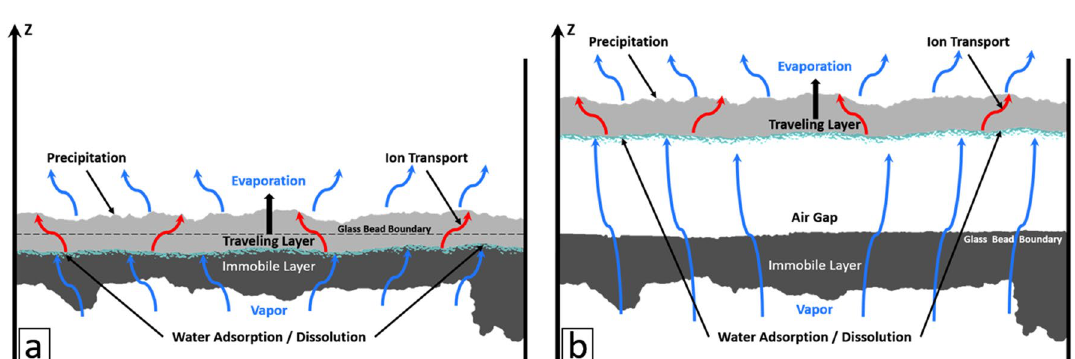
Figure 6. Schematic of displacement mechanism when the travelling layer is still embedded in the immobile layer ( a ) and after detachment ( b solution saturated crust pores, the brine NaCl concentration is expected to be very close to thermodynamic equilibrium. The vapor partial pressure at the surface of a NaCl saturated aqueous solution is p v − crust = 0.75 p vsat . These differences in vapor . As a result, the situation in the cell is p v − cell − bottom > p v − crust − surfaces > p v − cell − top partial pressures induce a water transport by diffusion between (1) liquid water at the cell bottom and the salt crust bottom and (2) the salt crust upper surface and the cell top. Consequently, the crust absorbs water at its bottom as the result of water vapor condensation whereas evaporation takes place at its top. Since the crust thickness does not change appreciably after detachment (Fig. 2), water does not accumulate significantly within the crust during the crust displacement. As a result, the water absorbed at the crust bottom is transported within the crust pore space up to the crust top surface, where it evaporates. This is an indication that the crust pore network is percolating. Hence, solute transport takes place through the crust while water vapor condensation at the crust bottom leads to crystal deliquescence 25 , i.e. dissolution, and evaporation at its top induces precipitation. This dissolution–precipitation displacement mechanism is sketched in Fig. 6. The displacement is quite slow. Thus, temperature variations associated with the liquid–vapor phase change processes occurring in the cell can be neglected. This scenario leads to the following relationships (adapted from ref. 26 ) relating the displacement of the travelling crust top and bottom surfaces with the evaporation flux (top surface) or the absorption flux (bottom surface), dz tct dt = mass fraction (26.4%), z tct is the travelling crust top surface mean position, z tcb is the travelling crust bottom surface mean position, j t is the evaporation flux at the travelling crust top surface, j b is the absorption flux at the travelling crust bottom surface, ε c is the crust porosity and Da is the Damköhler number characterizing the competition between the precipitation–dissolution reactions and ion transport within the crust 26 ; ε is the immo- bile bead layer porosity (taken equal to 0.36) when the travelling crust is partially embedded. After detachment, ε = 1 . The evolution of the travelling crust top and bottom surface positions within the cell was computed from these equations, using the evaporation flux determined from the mass loss experimental data, and the absorption flux from the liquid level variations in the cell and the adjacent cylinder. The corresponding curves are the blue and red dashed lines labelled “Model” in Fig. 2. The agreement between the model and the experimental data represents an additional element in favor of the dissolution–precipitation mechanism. Note that Da has been used as a fitting parameter, equal to 2.7 in the present study. Da requires information such as the crust interfacial area per unit volume or the crust effective diffusion coefficient 26 to be determined directly, i.e. not through a fitting procedure. This information is currently unavailable in literature. Whereas the displacements of the crust top and bottom surfaces are similar after detachment, it can be seen from Fig. 2 that the bottom surface displacement is faster than the top surface displacement before the